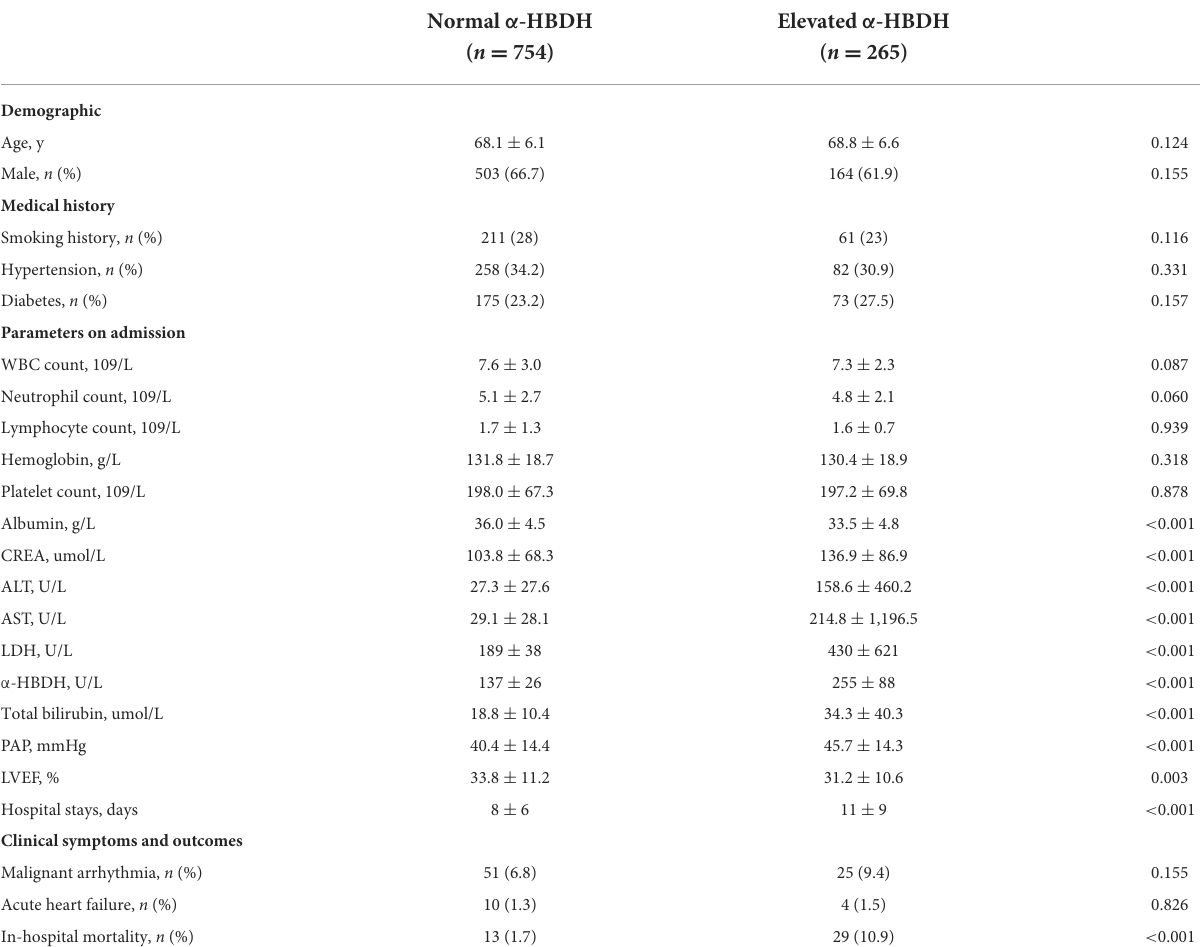
TABLE 1 Baseline demographics and clinical